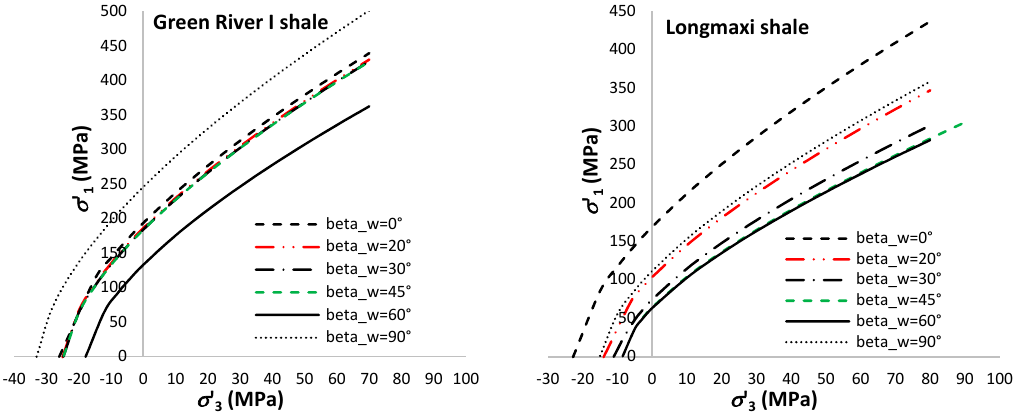
Figure 7. Hoek and Brown strength envelopes calculated with the instantaneous values of C o β w and m β w.